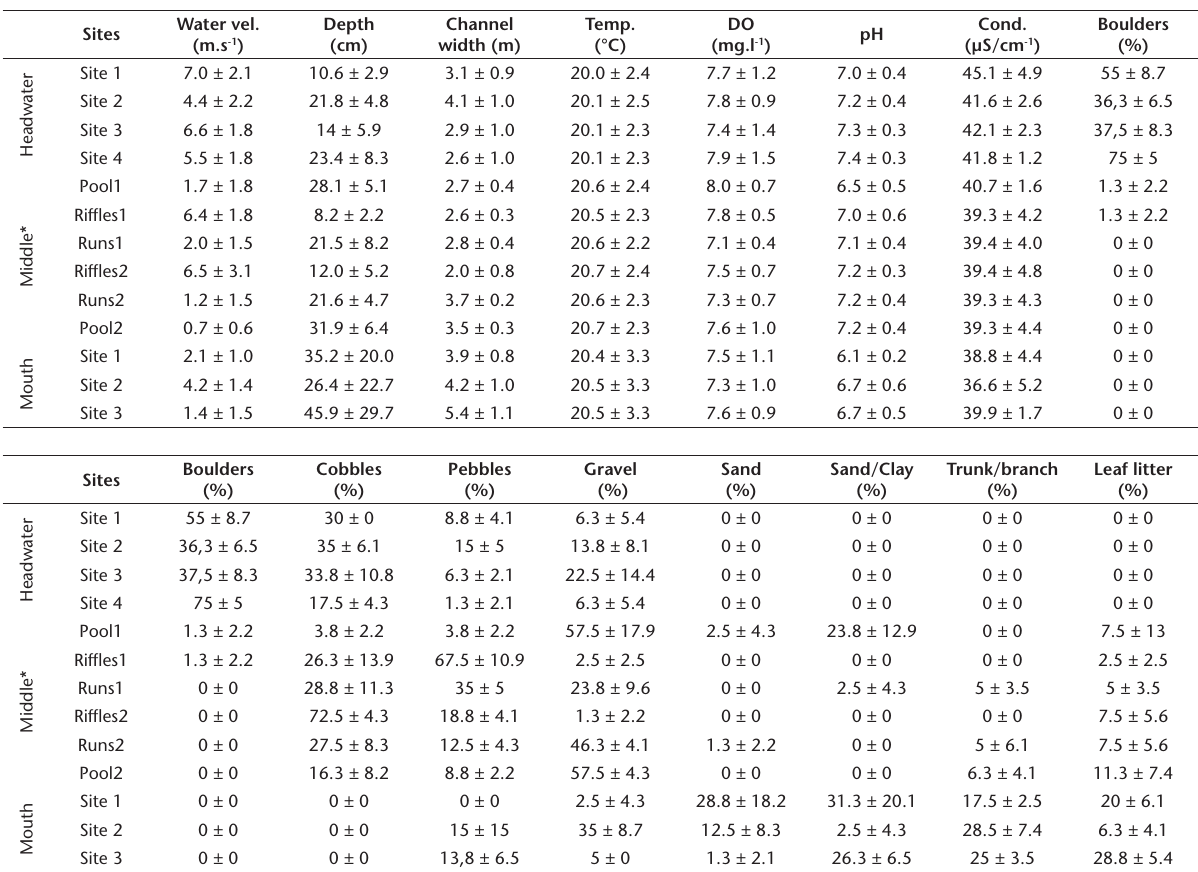
Table 1. Mean ± standard deviation of abiotic variables and main substrate bottom for sampling sites in headwater, middle and mouth reaches of the Vermelho River, Paraná state, Brazil. Temp. = temperature, DO = dissolved oxygen, Cond. = conductivity. Deviations rep- resent environmental variation between May 2009 and February 2010. * Sites at middle reach were classified as riffles, runs and pools. Water vel. Depth Channel Temp. DO Cond. Boulders Sites (m.s -1 ) (cm) width (m) (°C) (mg.l -1 ) (µS/cm -1 ) (%)